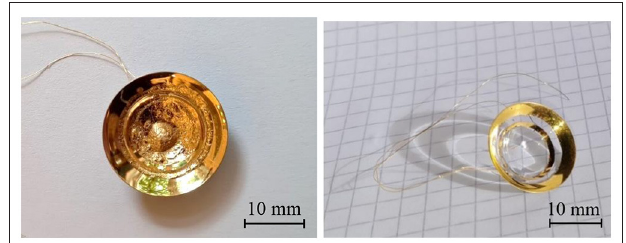
FIGURE 9 | The partially coated scleral contact lens electrode before (left) and after (right) the lift-off